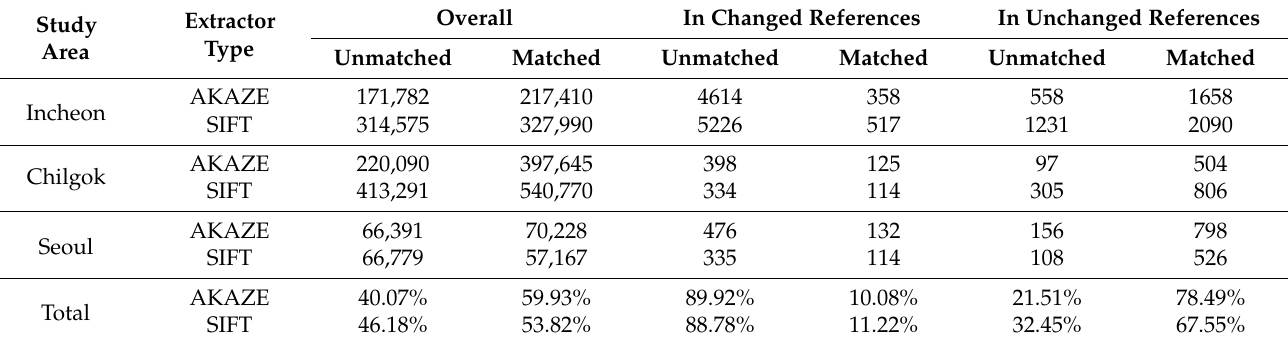
Table 4. Feature matching